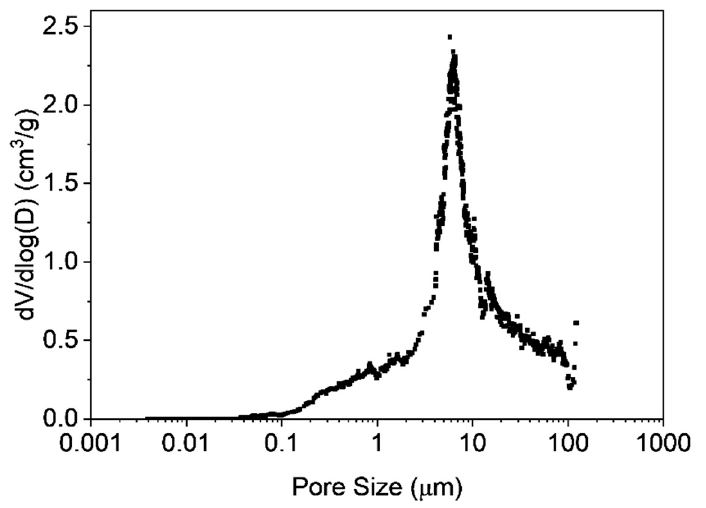
Figure 4. Differential pore size distribution of the microclusters by mercury intrusion experiments. The majority of the pores is in the order of several microns, whereas pores below 50 nm are virtually inexistent.